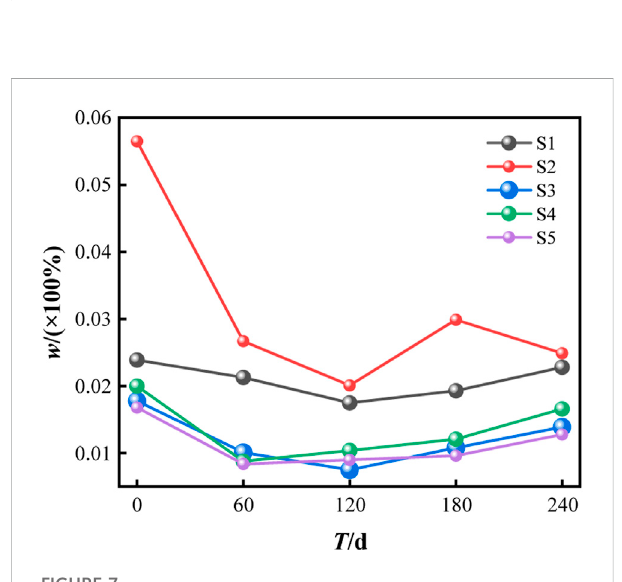
FIGURE 8 Change rule of mass loss